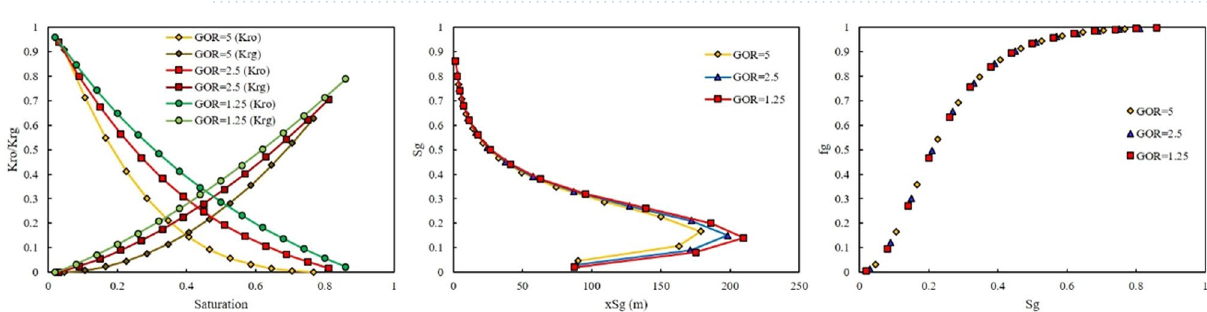
Figure 9. Effect of GOR of Naphtha on relative permeability, saturation profile, and fractional flow curve at an injection pressure of 1500 psi.